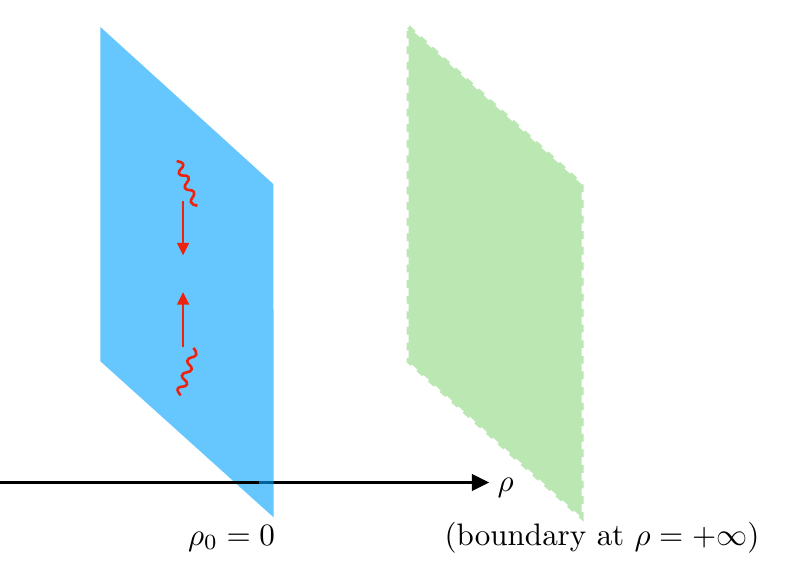
Figure 1 . Scattering of open strings in AdS, attached to a D-brane (blue) at coordinate ρ = 0 , for the metric given in eq.